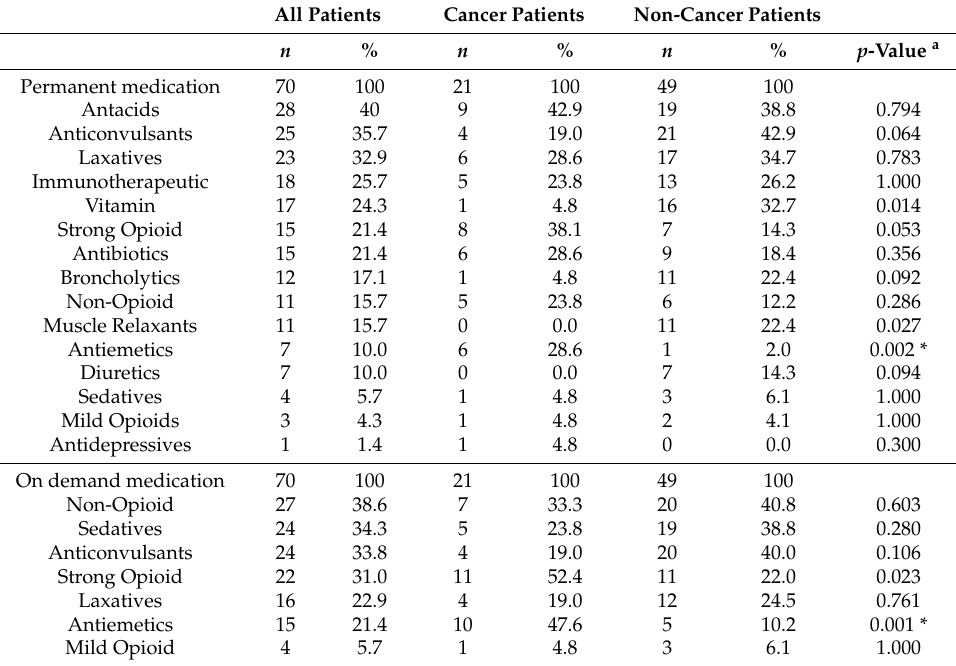
Table 6. Medication of cancer and non-cancer